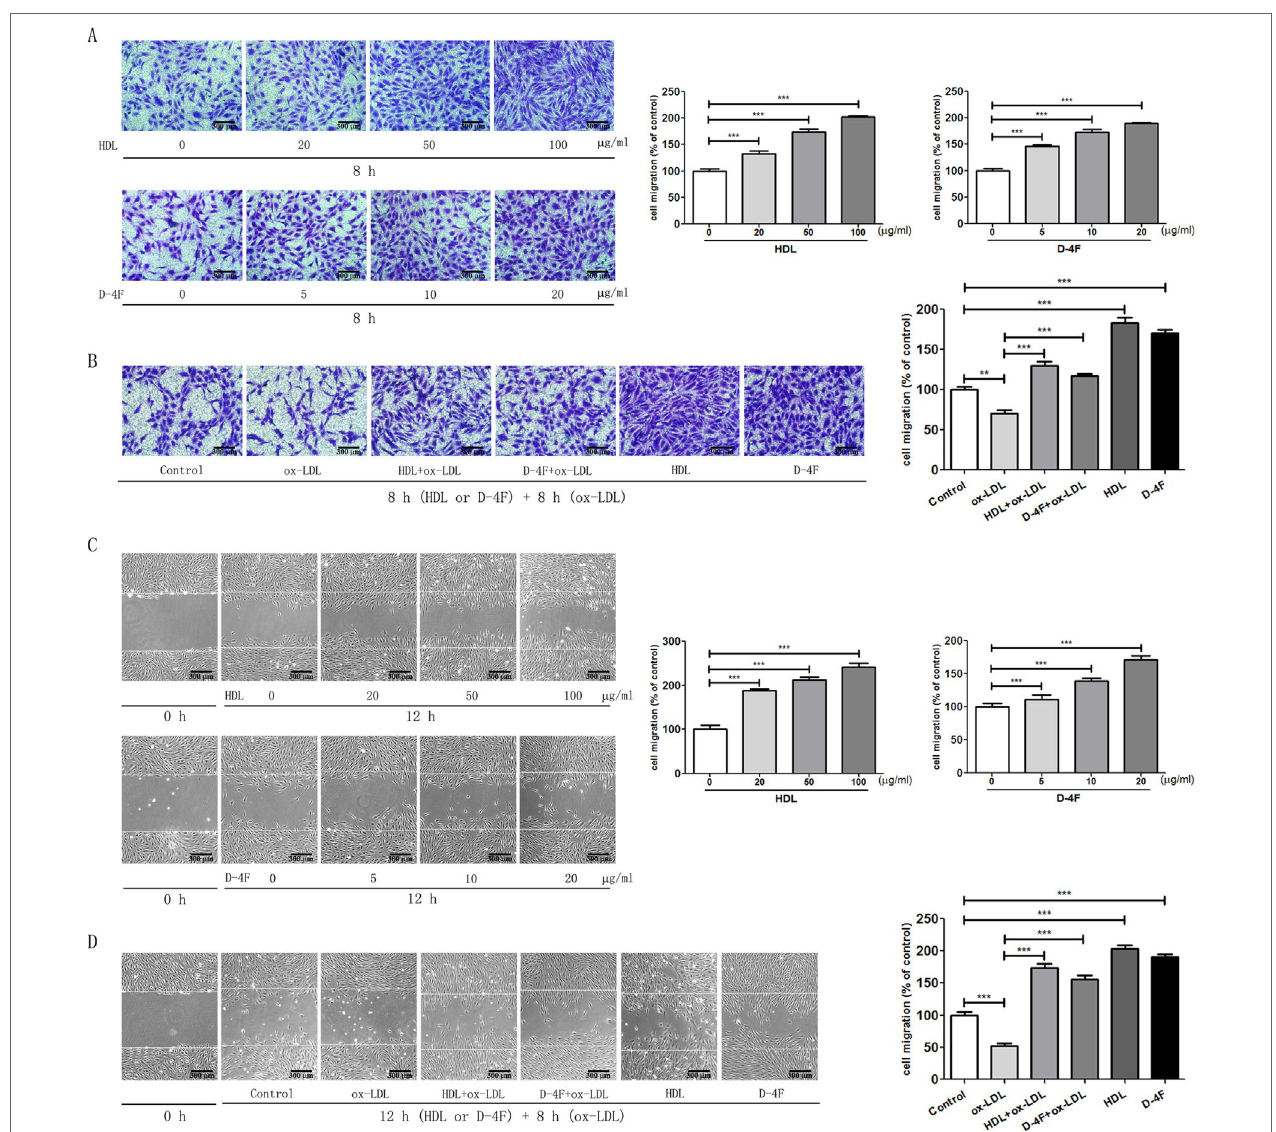
FIGURE 1 | HDL and D-4F promoted the migration of endothelial cells impaired by ox-LDL. Endothelial cells were incubated with various doses of either HDL or D-4F (A) for 8 h for transwell assay, or (C) for 12 h for wound healing assay. Alternatively, endothelial cells were pre-incubated with either HDL (100 μg/ml) or D-4F (20 μg/ml) for 8 h (B) or for 12 h (D) , and further treated with ox-LDL (100 μg/ml) for 8 h for transwell assay or for wound healing assay. Migrated cells were photographed and counted in six random high-power fields (100×). The bar length was 300 µm. * p < 0.05; ** p < 0.01; *** p <